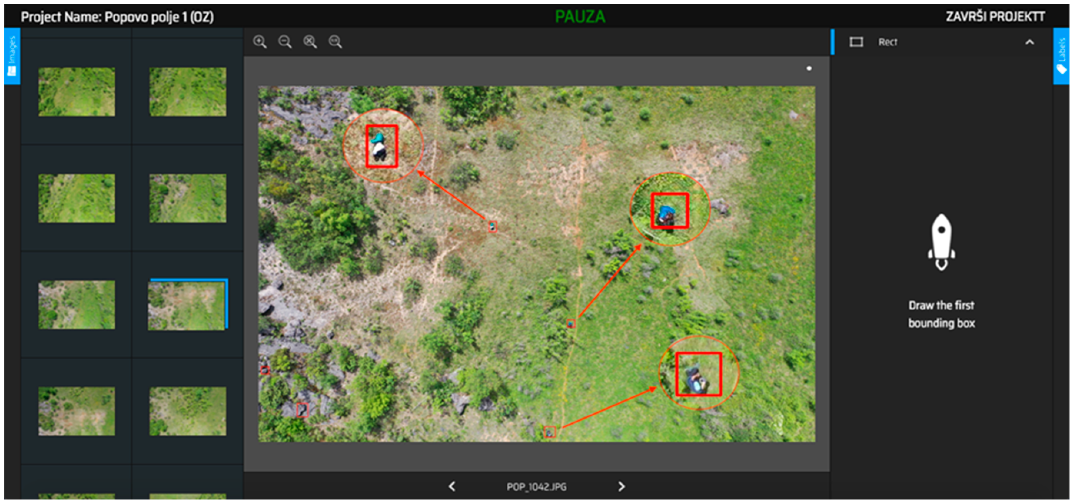
Figure 10. Main screen of the developed web application for detection accuracy comparison between the expert and the ScoreMap to ROI algorithm when the labelled mission is processed.